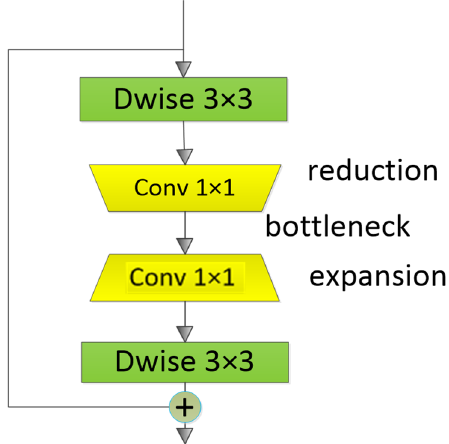
Figure 2. Sandglass block with bottleneck structure. Note: The bottleneck falls into the middle of the depth-wise convolutions, which have high-dimensional representations, so that the module encodes expressive spatial information.